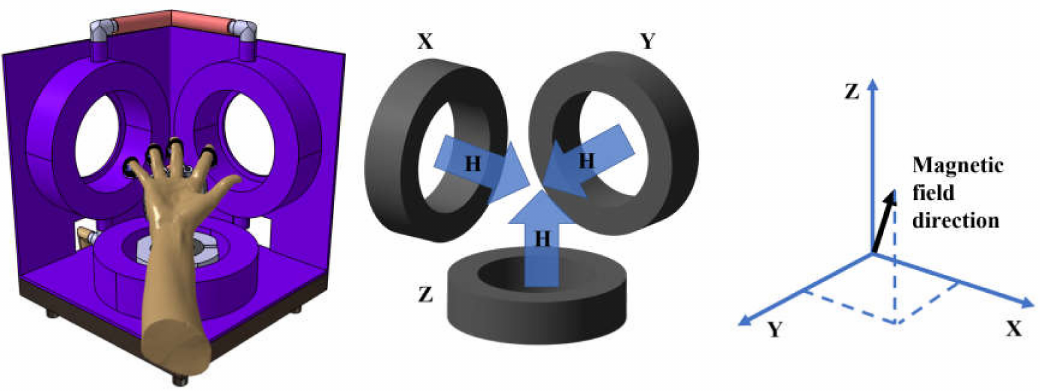
Figure 3. Direction of the magnetic